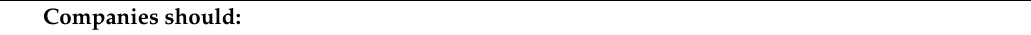
Figure S1: Ranking of companies by (a) mean Health Star Rating (HSR); (b) proportion of healthy products (HSR ≥ 3.5) and (c) proportion of products eligible for marketing to children (all without sales-value-weighting); Table S1: Product categorization—Euromonitor sub-categories and equivalent HSR and WHO Euro categories by category number and description *; Table S2: Alignment of nutrients required for profiling models with those required by Indian labelling legislation; Table S3: Number of food and beverage products by company in Euromonitor sub-categories; Table S4: Distribution of Health Star Rating (HSR) by company; Table S5: Mean and range Health Star Rating (HSR) of products by Euromonitor sub-category, all